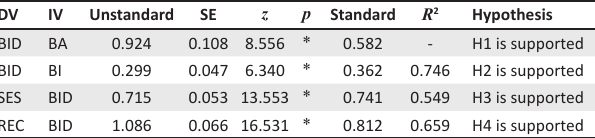
TABLE 4: Hypothesis test of the research model.